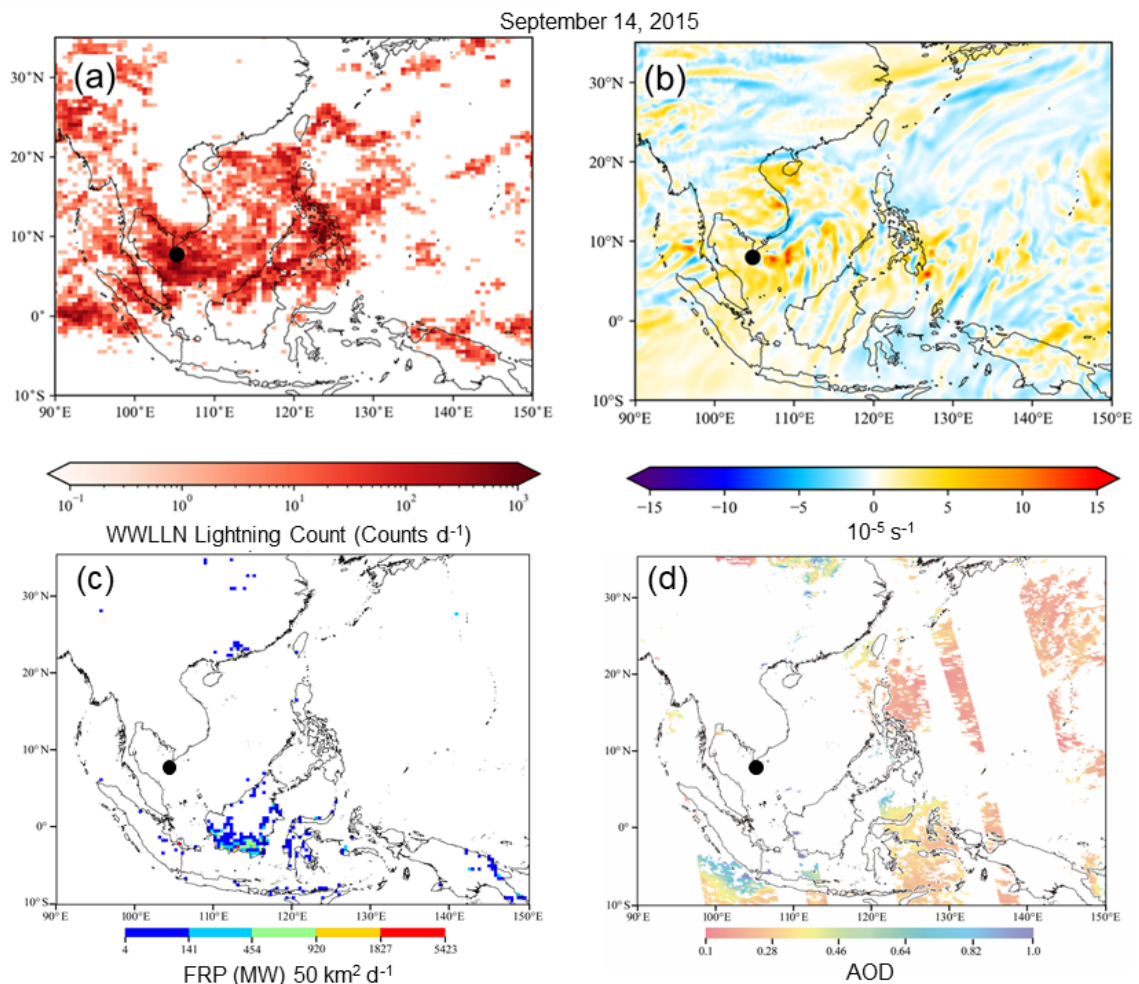
Figure 13. Spatial distribution of (a) lightning counts per day from the WWLLN database, (b) horizontal wind divergence at 200hPa from the ERA5 reanalysis, (c) fire radiative power (FRP) density 5km − 2 d − 1 from MODIS and (d) the aerosol optical depth (AOD) derived from the MODIS sensor in the Aqua satellite (nadir pass at 13:30LT), for the EIE event recorded on 14 September 2015 (black